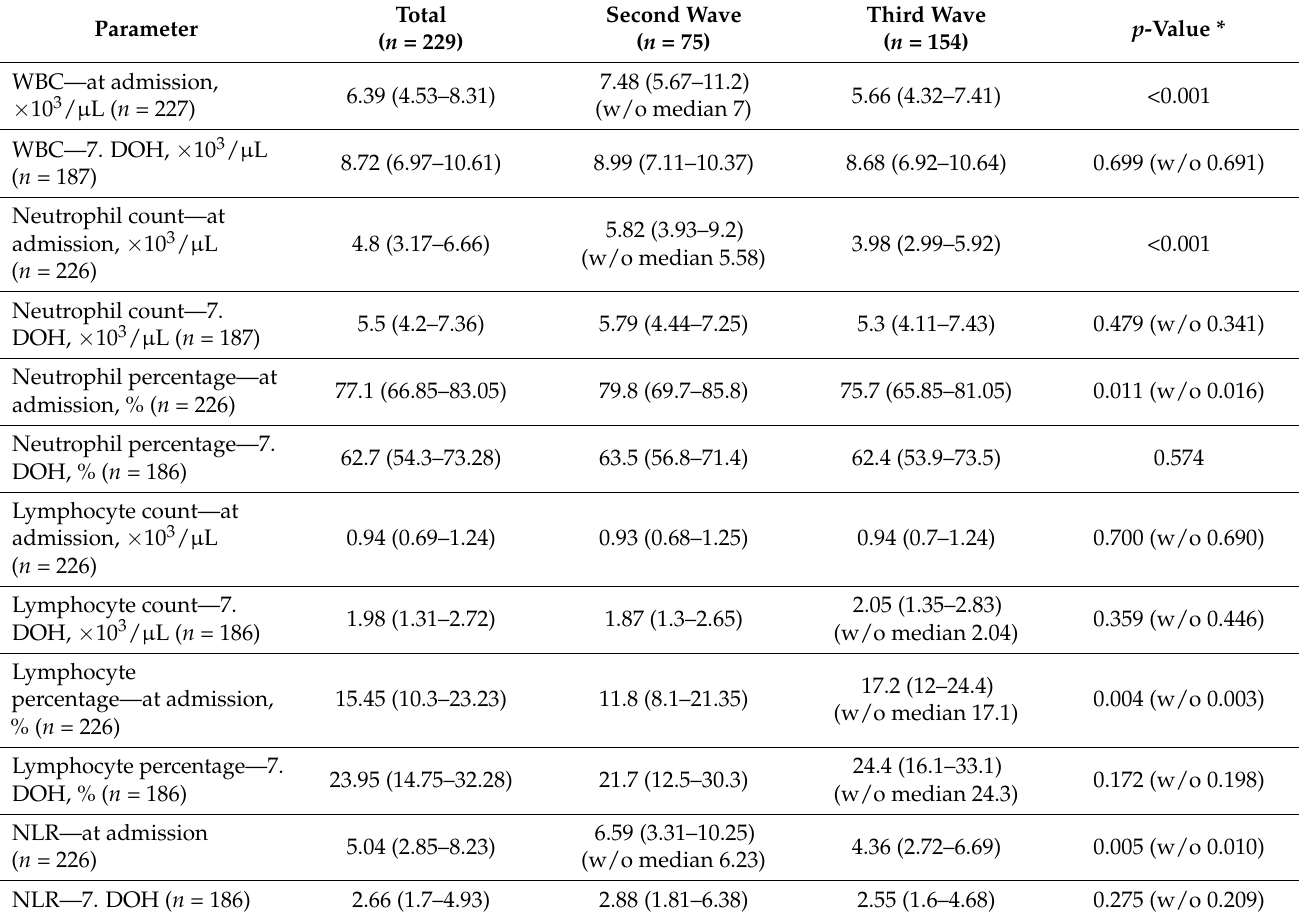
Table 3. Comparison of patients’ laboratory parameters (as continuous variables) between the second and the third